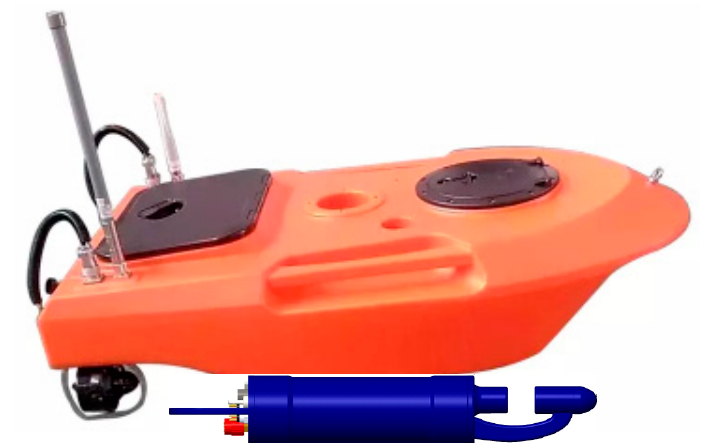
Figure 1. Marine Drone With LISST-Holo2.